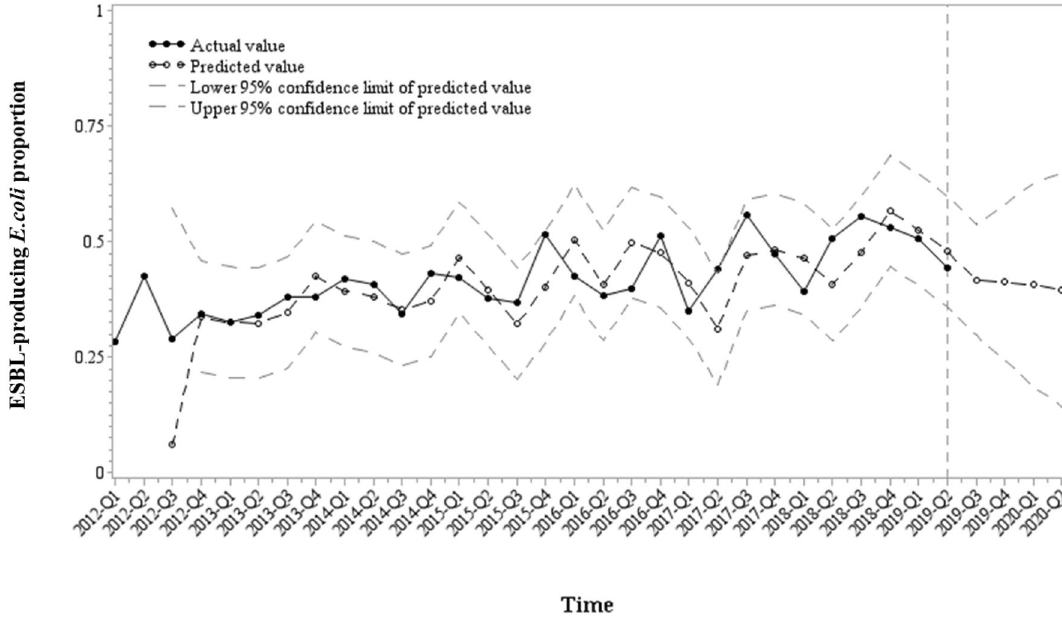
Figure 3. Predicted and observed ESBL-producing E. coli proportion upon ciprofloxacin